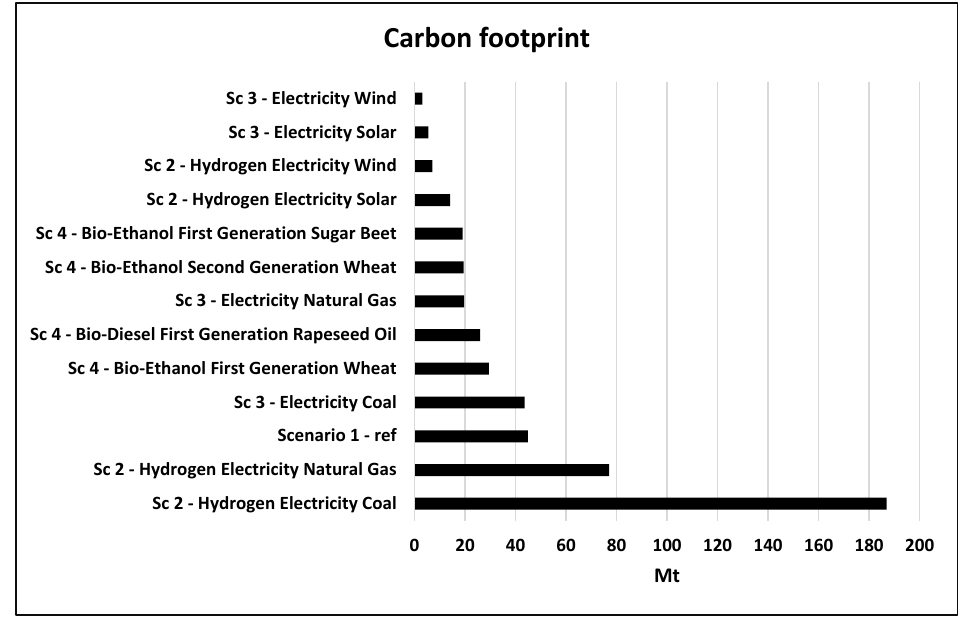
Figure 7. Annual carbon footprint of the four scenarios for transport fuels in the Netherlands, including the reference scenario for fuel use in 2016 (Mt CO 2 e).